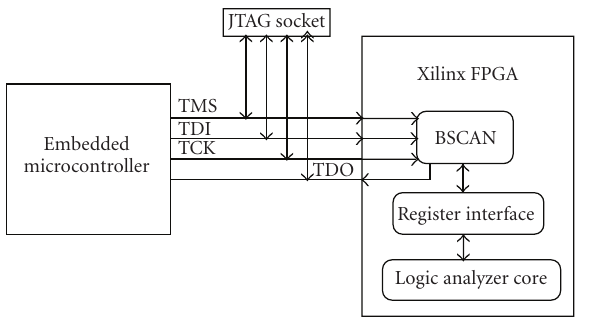
Figure 9: High-level FPGA connection to JTAG